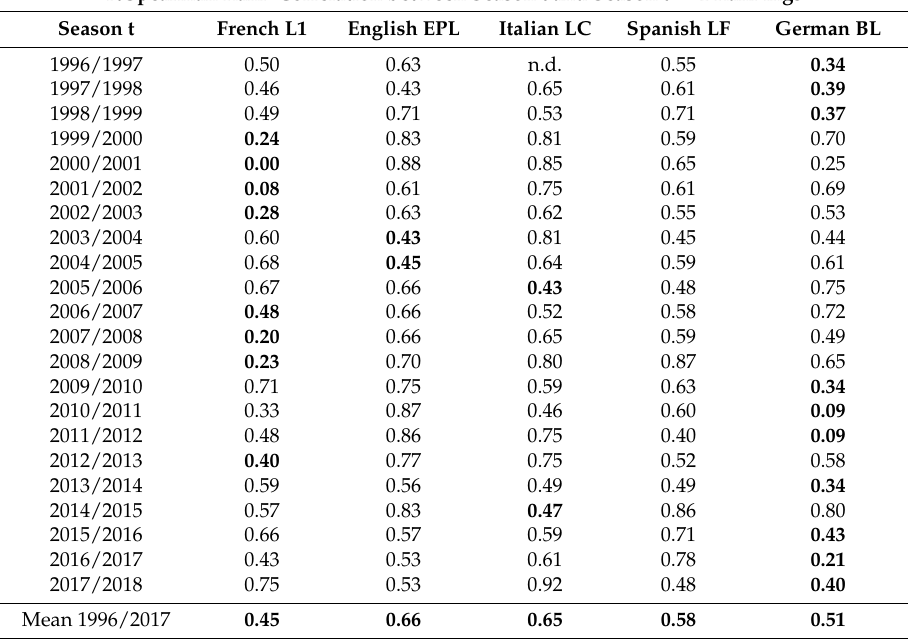
B/Spearman Rank Correlation between Season t and Season t − 1